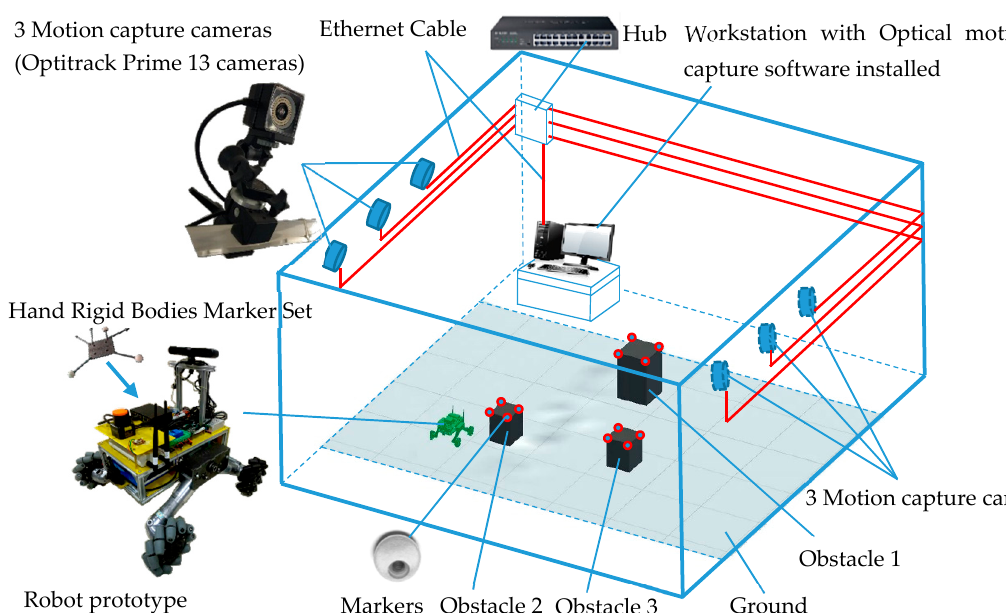
Figure 39. Navigation test system of the robot prototype using the Optitrack optical motion capture system.